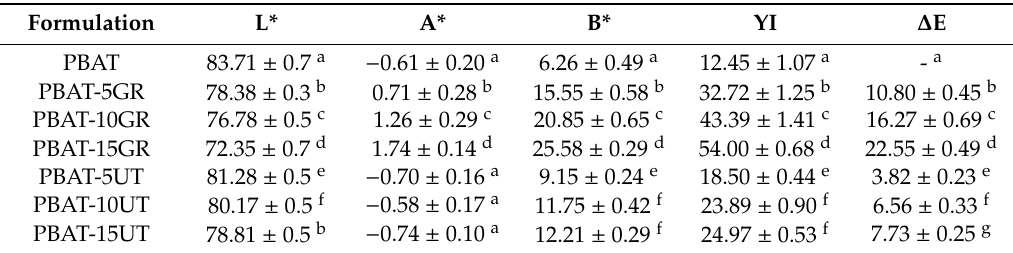
Table 2. Colour parameters for the CIEL*a*b* space of PBAT and PBAT-resin formulations. Formulation